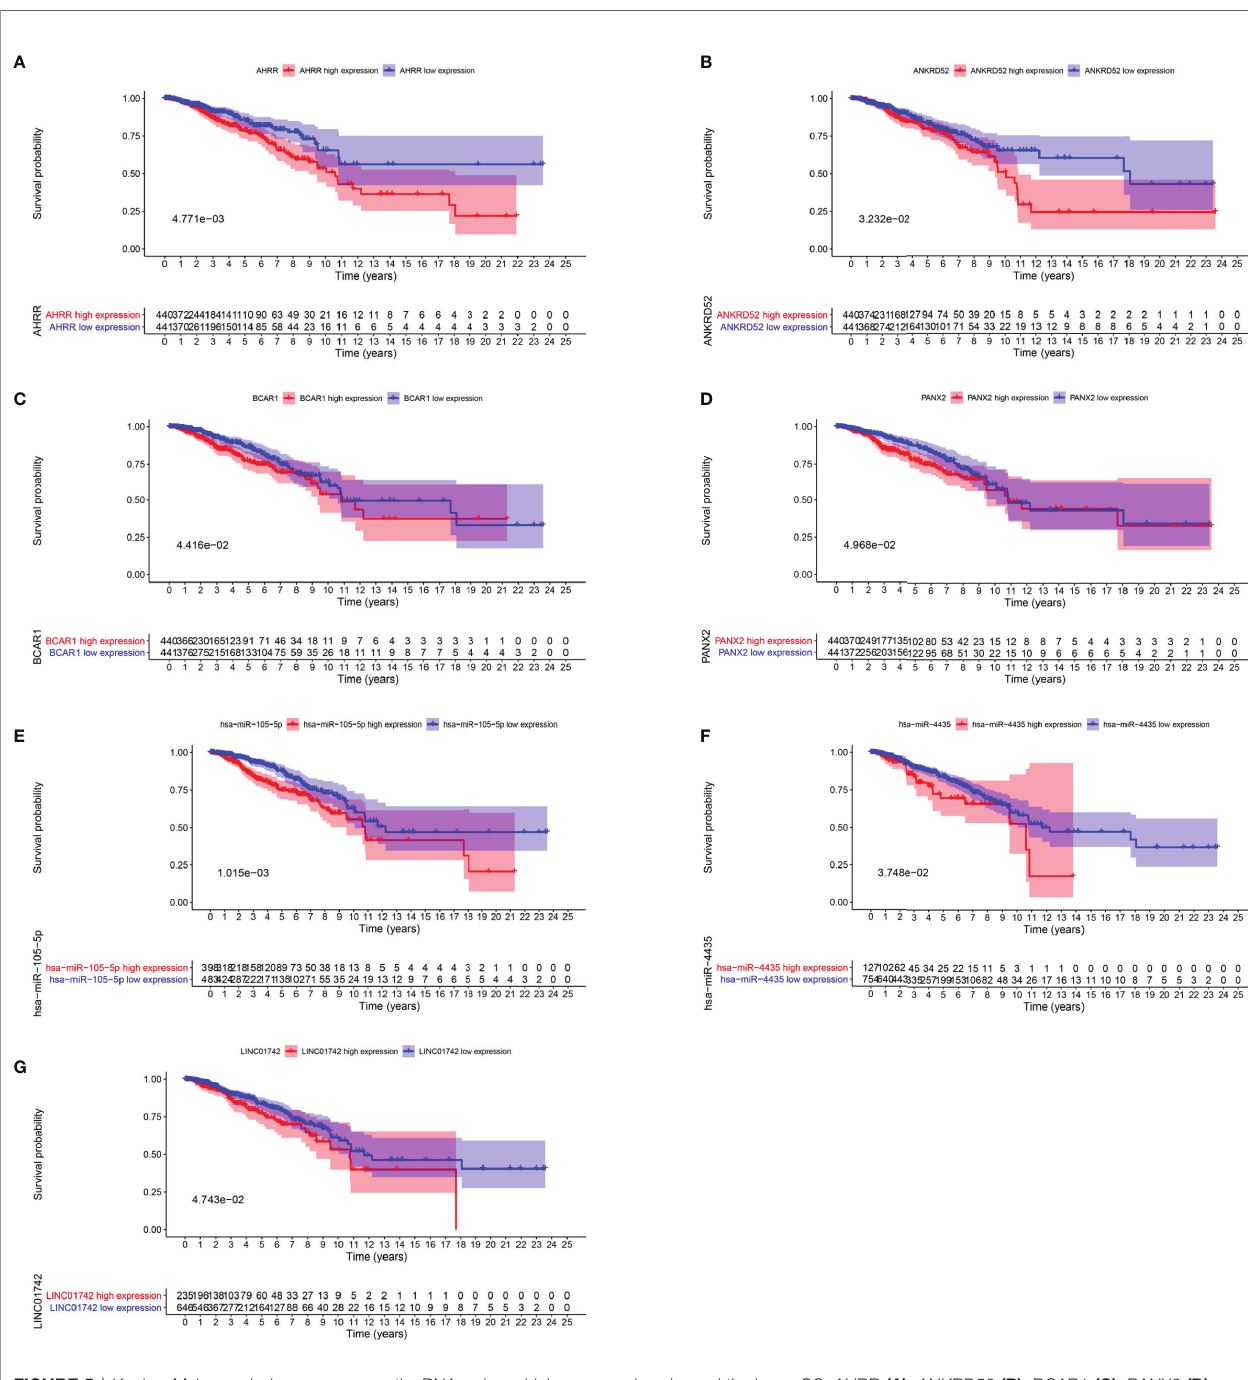
FIGURE 5 | Kaplan – Meier survival curves prognostic. RNAs whose higher expression showed the lower OS. AHRR (A) , ANKRD52 (B) , BCAR1 (C) , PANX2 (D) , hsa-miR-105-5p (E) , hsa-miR-4435 (F) , LINC01742 (G)